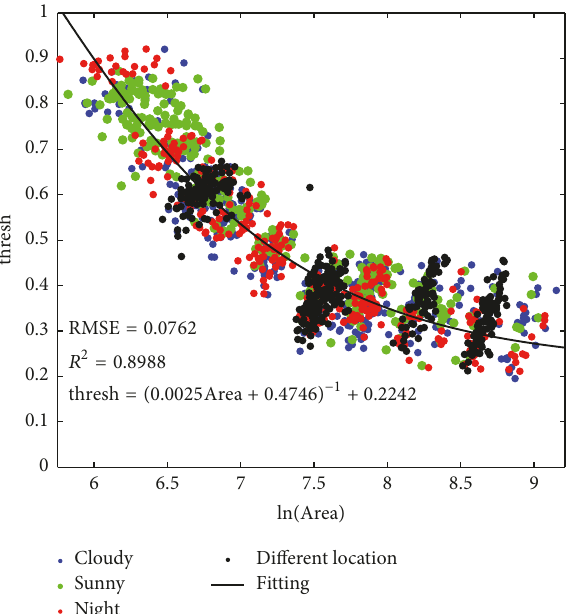
Figure 13: The relationship between thresh and particle pixel area.